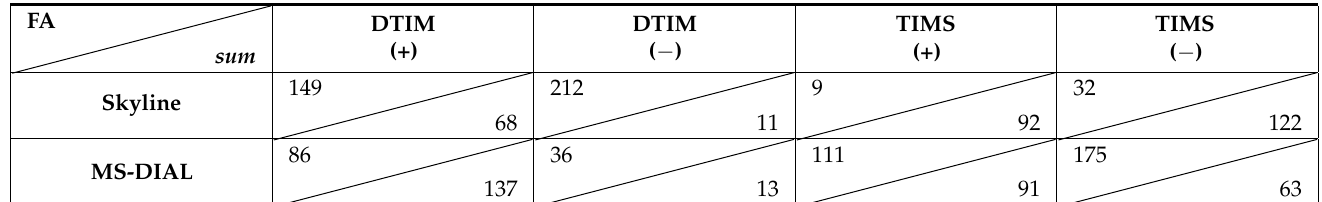
Table 2. Summary of lipid identifications from DTIMS and TIMS evaluation data in positive (+) and negative ( − ) ionization modes using Skyline and MS-DIAL. Each contains the count of lipid identifications made at levels that include individual fatty acid composition (FA) or only sum composition